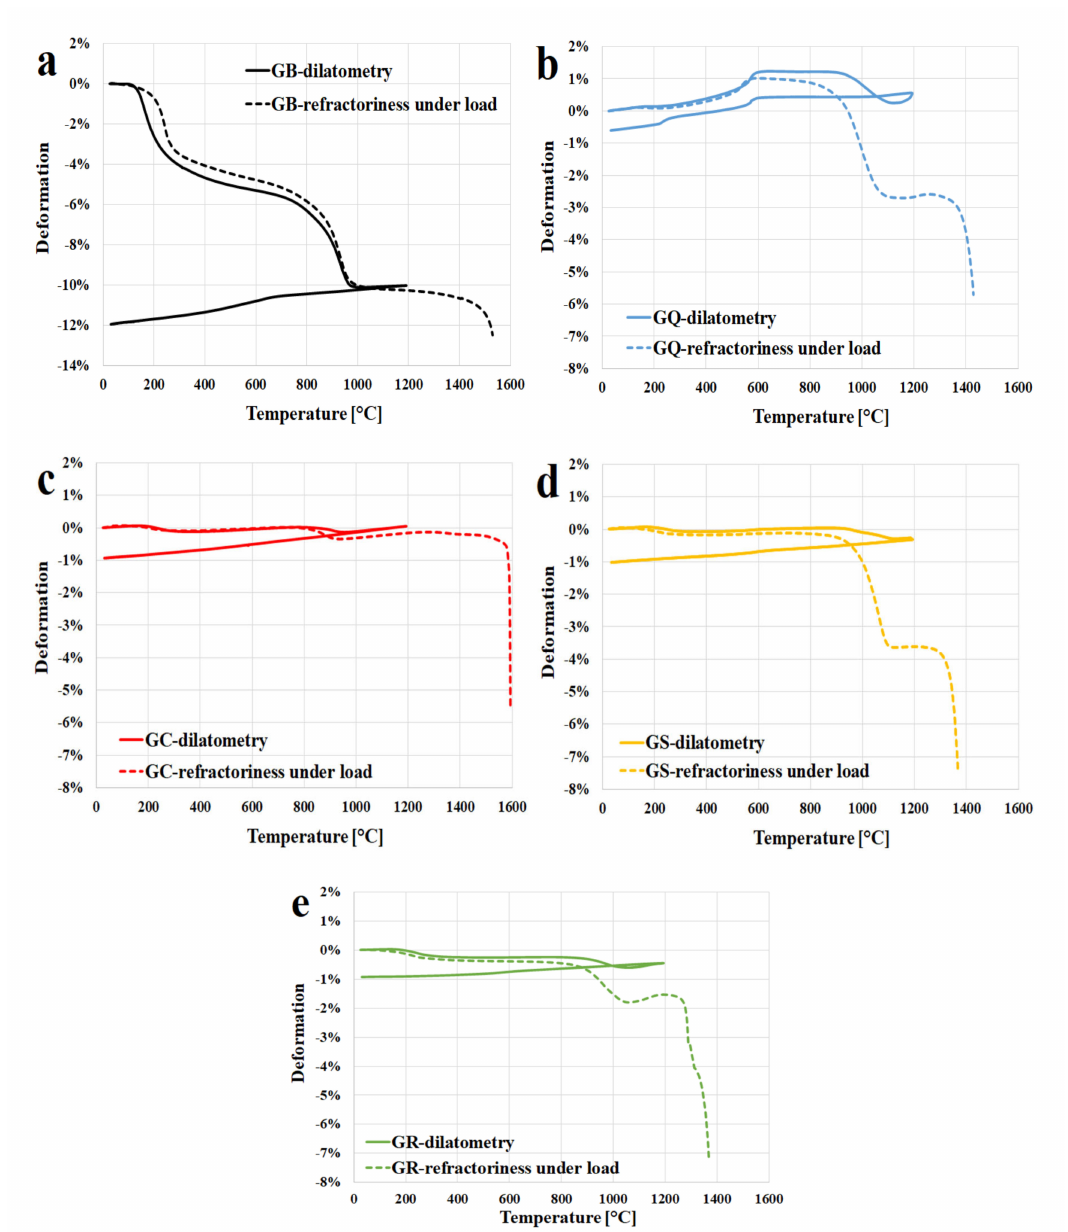
Figure 5. Comparison of refractoriness under load in relation to dilatometry geopolymer binder ( a ) and composites ( b —quartz, c —corundum, d —chamotte, e